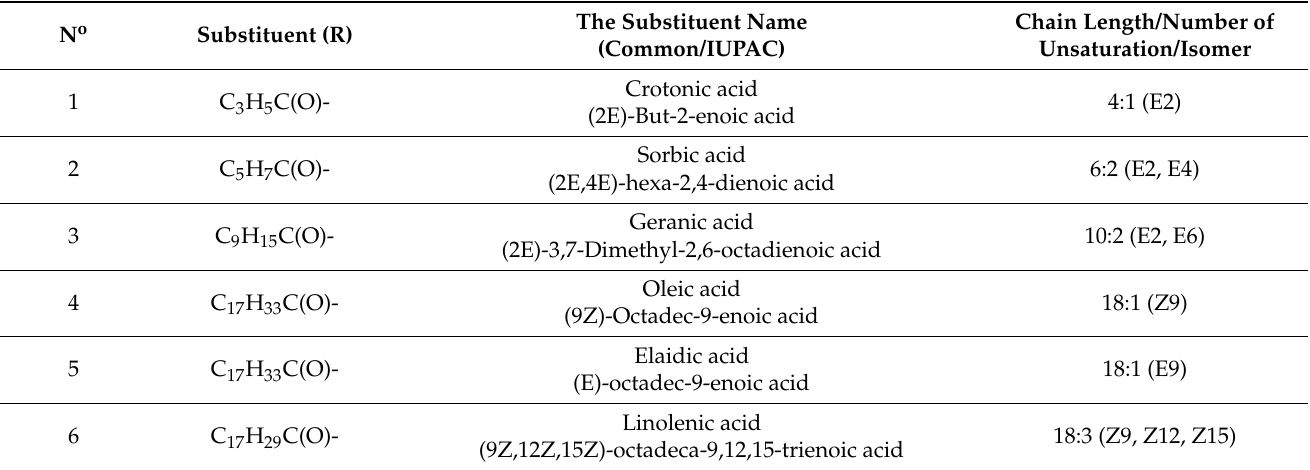
Table 1. Fatty acids being substituents in the structure of the tested compounds.